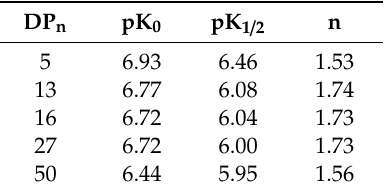
Table 2. The values of pK 0 , pK 1 / 2 and n of COS varying in DP (see